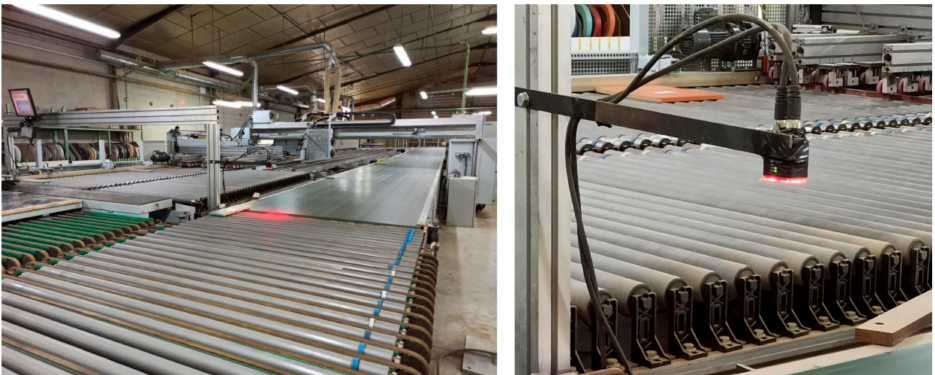
Figure 8. Camera scanning pieces in the conveyor of the edge banding